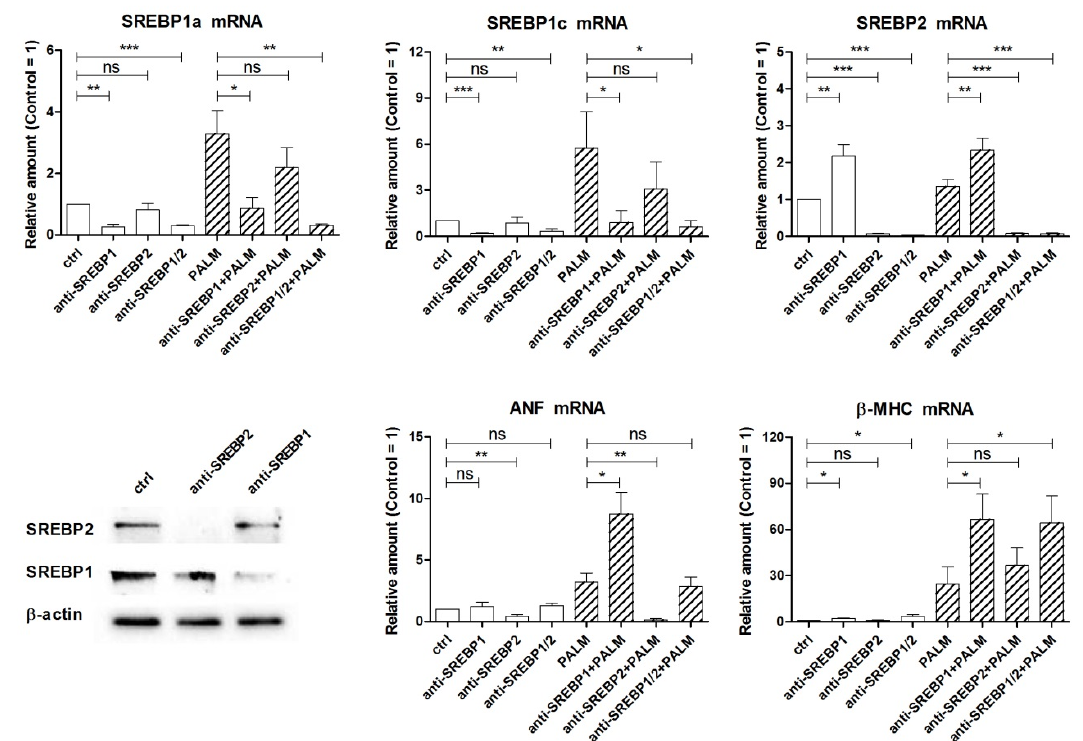
Figure 6. Effect of SREBP siRNAs on SREBP mRNA levels and hypertrophy of H9c2 cardiac cells exposed to palmitate. Cells were transfected for 24 h with SREBP1 siRNA and/or SREBP2 siRNA (indicated as anti-SREBP in the figures). After a 24 h incubation with or without palmitate, as indicated, cells were analyzed by RT-PCR for the relative amount of SREBP1a, SREBP1c, SREBP2, ANF, and β-MHC mRNAs. Western blot of SREBP1 and SREBP2 is reported to show the effectiveness of silencing. Differences are indicated with ns (not significant) for a p -value > 0.05, or with *, **, ***, for p < 0.05, p < 0.01, and p < 0.001, respectively.